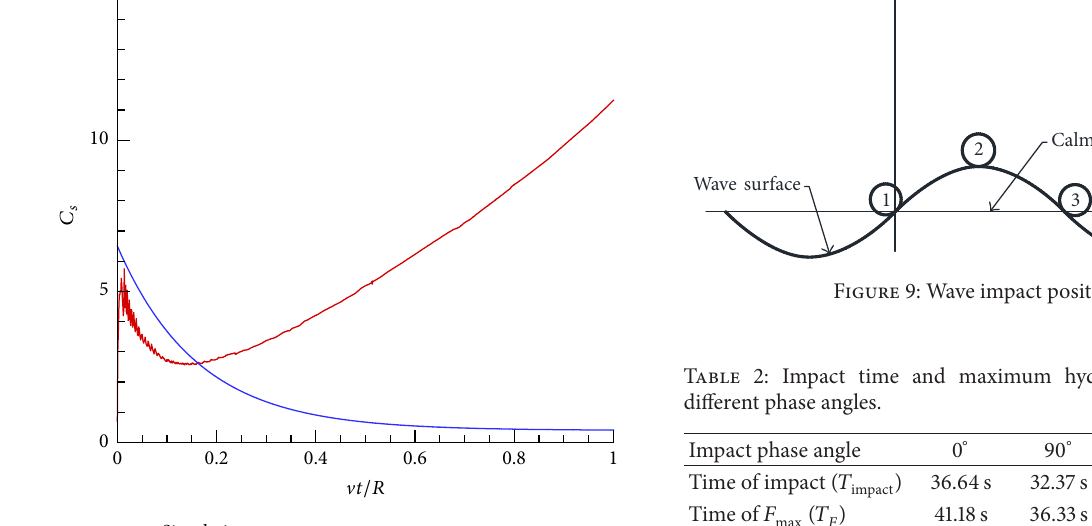
water particles and thus the increase of 𝐶 𝑠 . Secondly, the wave surface surrounding circular cylinder varies rapidly and cylinder and water particles.